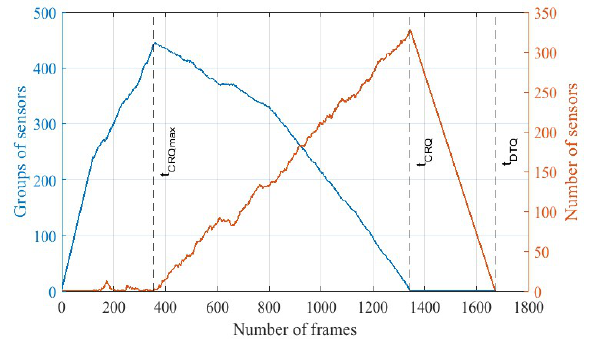
Figure 3. Average collision resolution time